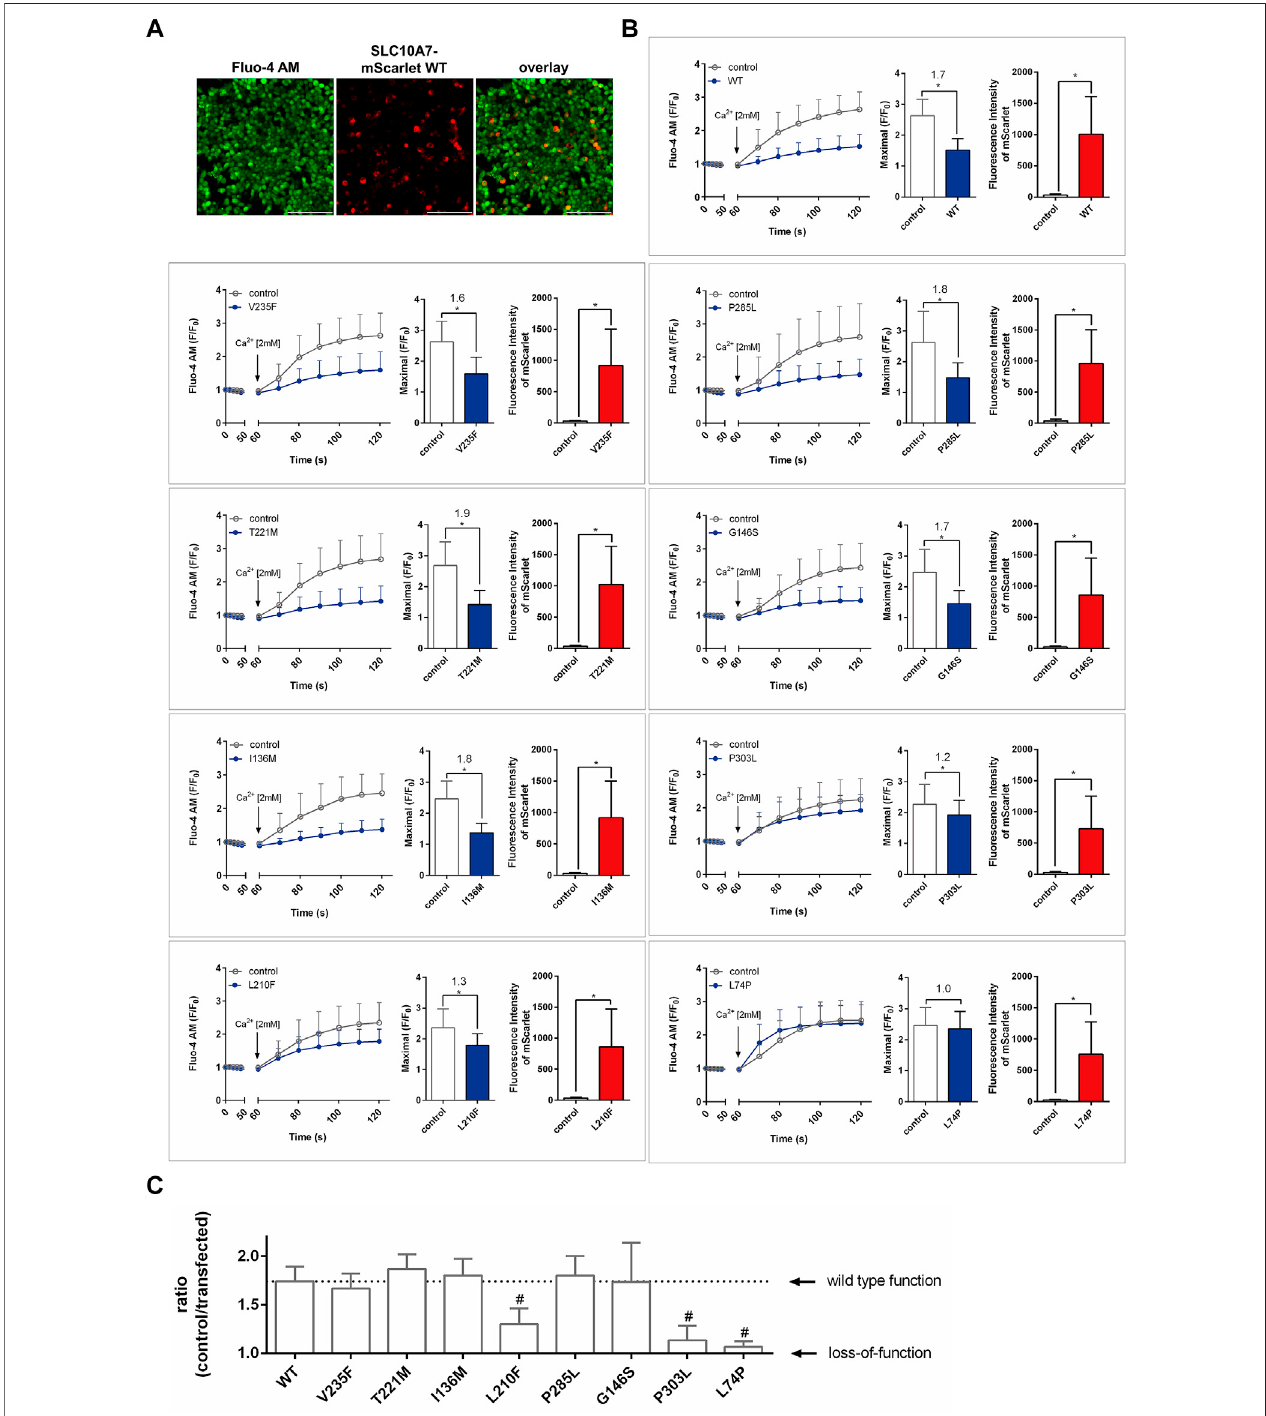
FIGURE 4 | EffectsofSLC10A7-mScarletwild-type(WT) and mutantconstructsonCa 2+ in fl uxintoHEK293cells. Allconstructsweretransientlytransfected intoHEK293 cells.Aftertransfection,cellswerepreparedforcalciumimagingbypre-incubationinFluo-4AMandthapsigargin(TG),followedbytheadditionofextracellularCa 2+ .Red(mScarlet) and green (Fluo-4) fl uorescence signals were recorded every 10 s. (A) Fluo-4 fl uorescence signals were analyzed separately, (I) in additional red fl uorescent cells (considered SLC10A7-mScarlet-expressing cells) and (II) non-red fl uorescent cells (untransfected controls). (B) The left bar graphs represent the maximal induced Ca 2+ fl uorescence (maximummean fl uorescenceatanytimepoint)inbothcelltypes,andtherightbargraphsindicatethe fl uorescenceintensitiesoftheSLC10A7-mScarletfusionproteins.Statistical analysiswasperformed usingStudent ’ sttest.* Signi fi cantly differentat p < 0.01. (C) EffectsofthedifferentSLC10A7/RCASvariantsoncellular Ca 2+ in fl ux.Ratios(Ca 2+ in fl uxin non-transfected cellsvs Ca 2+ in fl uxinSLC10A7/RCAS-expressing cells) indicatetheeffectoftheexpressedSLC10A7/RCASproteinontheCa 2+ in fl ux.Variantswithratiosnear thevalueof1.0areconsideredasloss-of-functionvariants.Statisticalanalysiswasperformedusingone-wayANOVA.#Signi fi cantlydifferentfromWTat p < 0.01.Datarepresent means ± SD of approximately 230 – 256 individual cells from three independent experiments ( n (cid:2) 3). Scale bars: 214 µm.